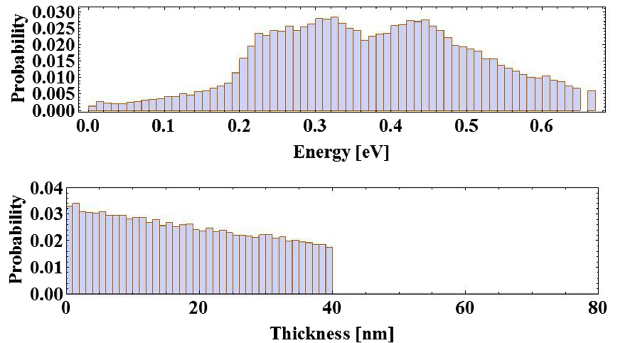
FIG. 7. (top) The histogram of the electron-energy distribution in the conduction band excited by 2.32 eV laser photons at room temperature; the electron energy is ( ℏ ω − E ) with a resolution of g 0.01 eV. The Y axis is the probability distribution of electrons at different energies. (bottom) The longitudinal distribution of excited electrons along the cathode ’ s thickness (40 nm) with exponential decay.